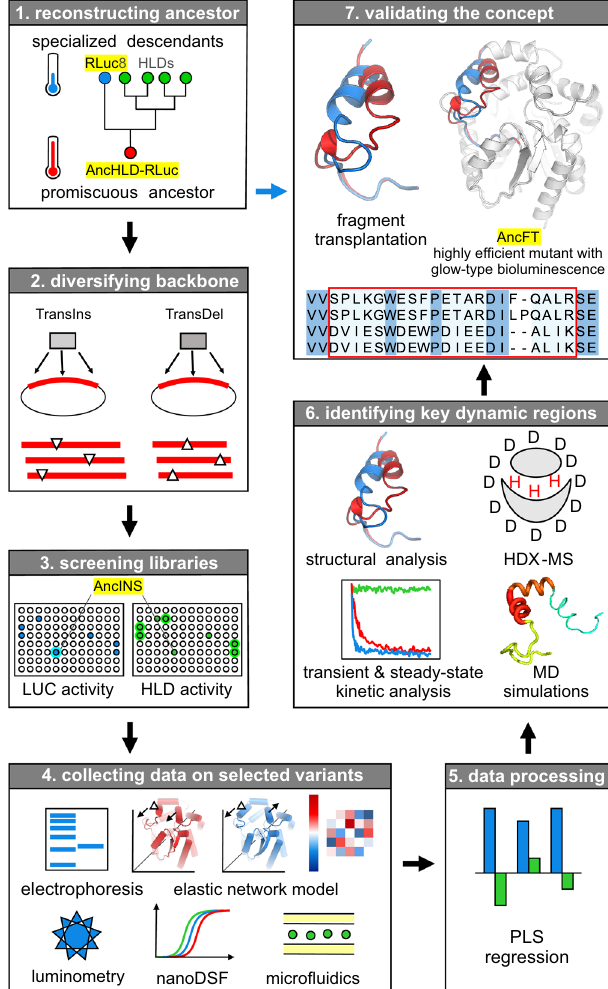
Fig. 1 Illustration of the strategy for semi-rational engineering of protein dynamics. Exploratory phase — 1 A thermostable ancestral protein, Anc HLD- RLuc , provided a robust and evolvable template that can withstand the destabilizing effects of protein backbone engineering. 2 Libraries of